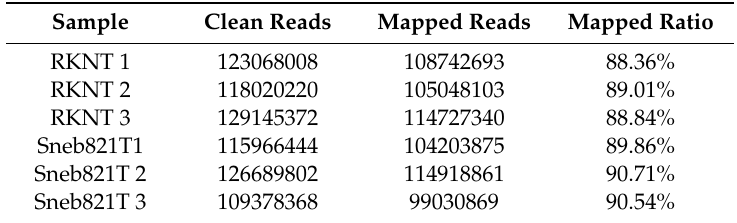
Table 1. Raw reads were produced from six cDNA libraries of tomato samples.